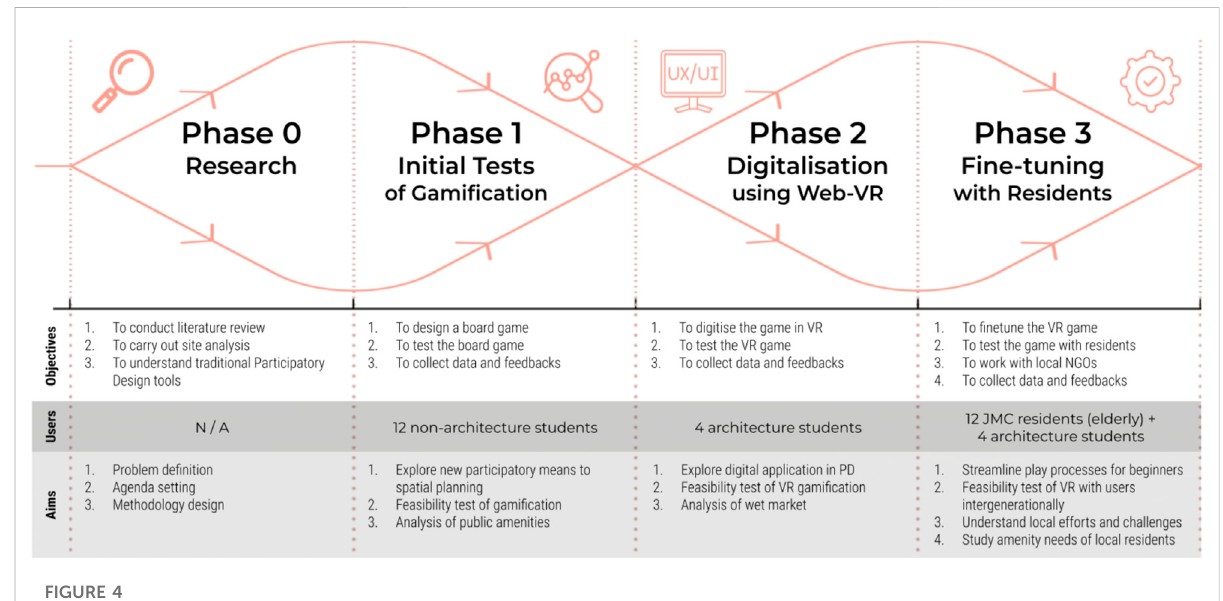
FIGURE 4 The four phases of the project ’ s